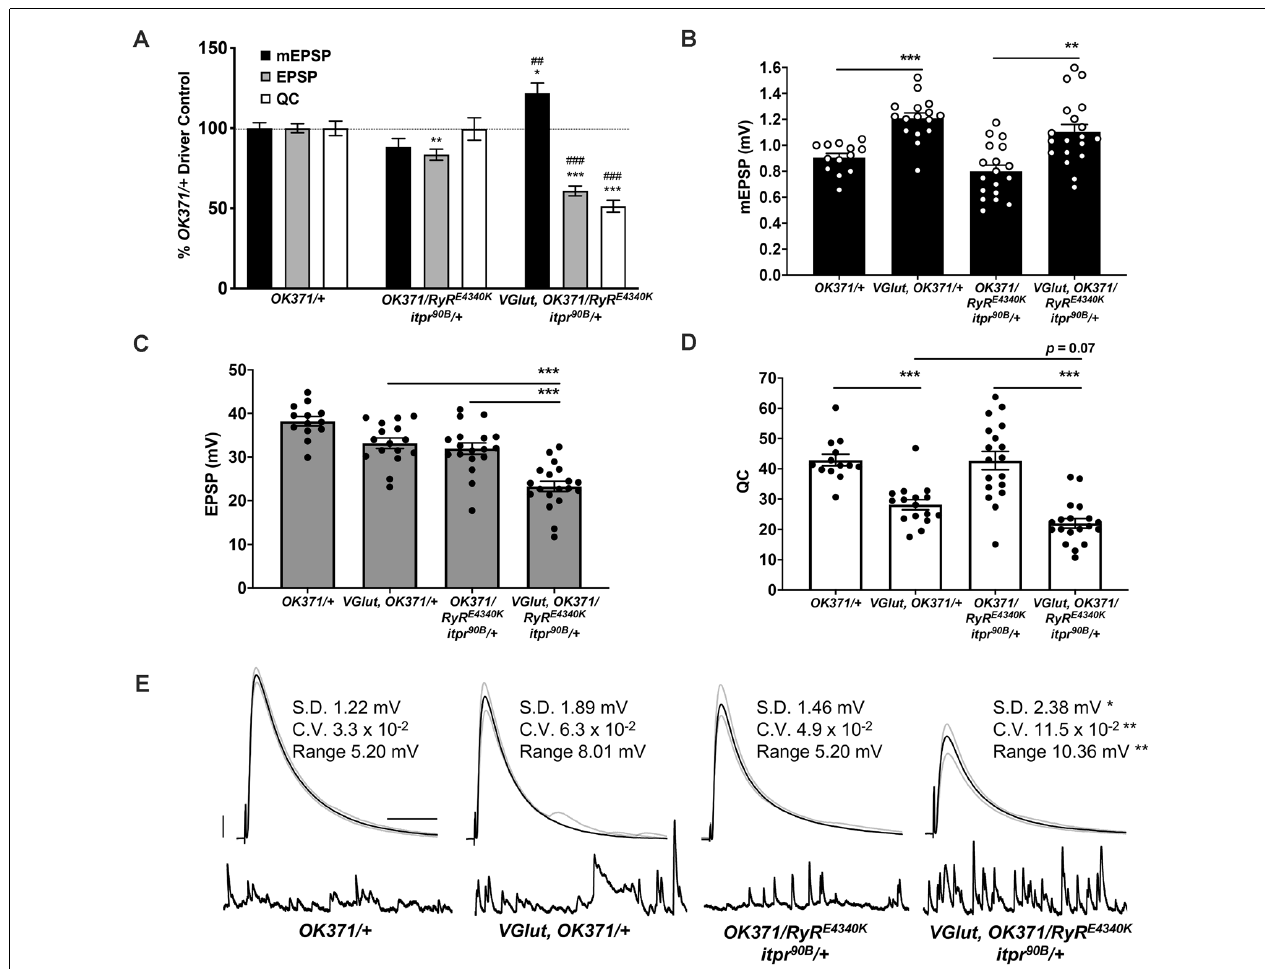
FIGURE 3 | Double heterozygous loss of the itpr and RyR genes interacts with the PHD challenge to diminish neurotransmission. Note: traces and data for OK371/+ and VGlut, OK371/+ are repeated from Figure 1 , for genetic background comparison. Abbreviations are as in Figure 1 . (A) NMJ electrophysiological data for mEPSP, EPSP, and QC. Data are normalized to OK371/+ values. * p < 0.05, ** p < 0.01, and *** p < 0.001 vs. OK371/+ ; ## p < 0.01 and ### p < 0.001 vs. OK371/RyR E4340K ; itpr 90B /+ ; analyses by one-way ANOVA with Tukey’s post-hoc . (B) Raw data for mEPSPs. (C) Raw data for EPSPs. (D) Raw data for QC. For (B–D) , bars are averages and error bars are ± SEM. * p < 0.05, ** p < 0.01, and *** p < 0.001 by one-way ANOVA across genotypes, with Tukey’s post-hoc . (E) Representative electrophysiological traces with standard deviation (SD), coefficient of variation (CV) and range values for EPSPs. The SD, CV, and range were